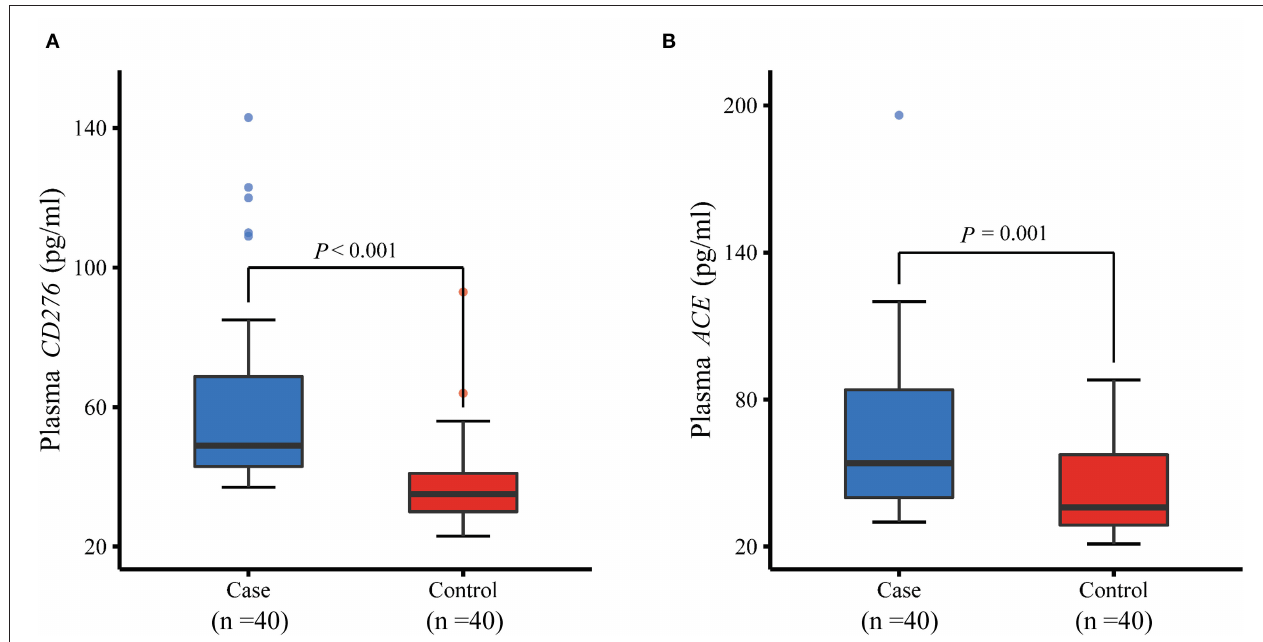
FIGURE 4 | Comparison of plasma protein levels of CD276 and ACE between MPP cases and controls measured by ELISA. (A) Plasma protein level of CD276 was significantly higher in children with MPP than in healthy controls ( P < 0.001). (B) Plasma protein level of ACE increased considerably in children with MPP compared with healthy controls ( P = 0.001). ELISA, enzyme-linked immunosorbent assay; MPP, Mycoplasma pneumoniae